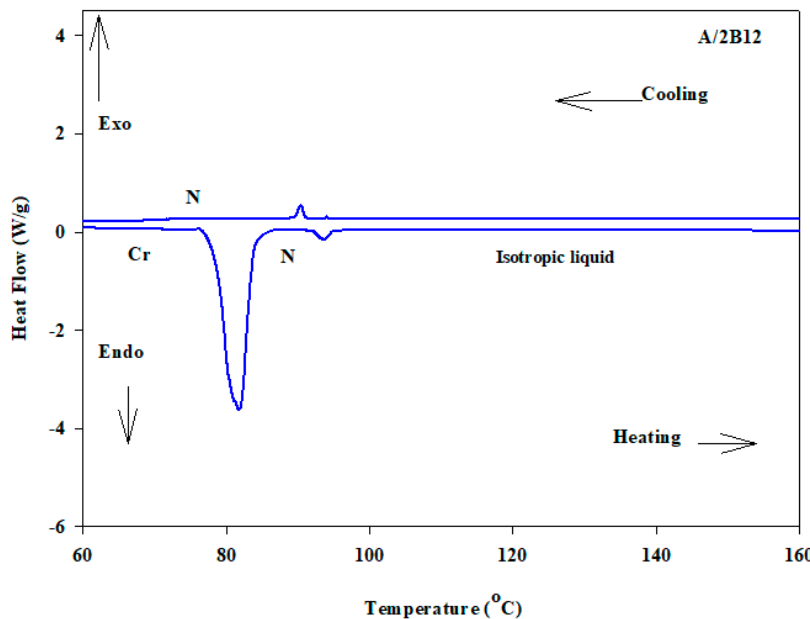
Figure 2. Differential scanning calorimetry (DSC) curve at rate 10 °C/min for 1:2 HBSMC, A/2B12 upon the second heating/cooling cycles.